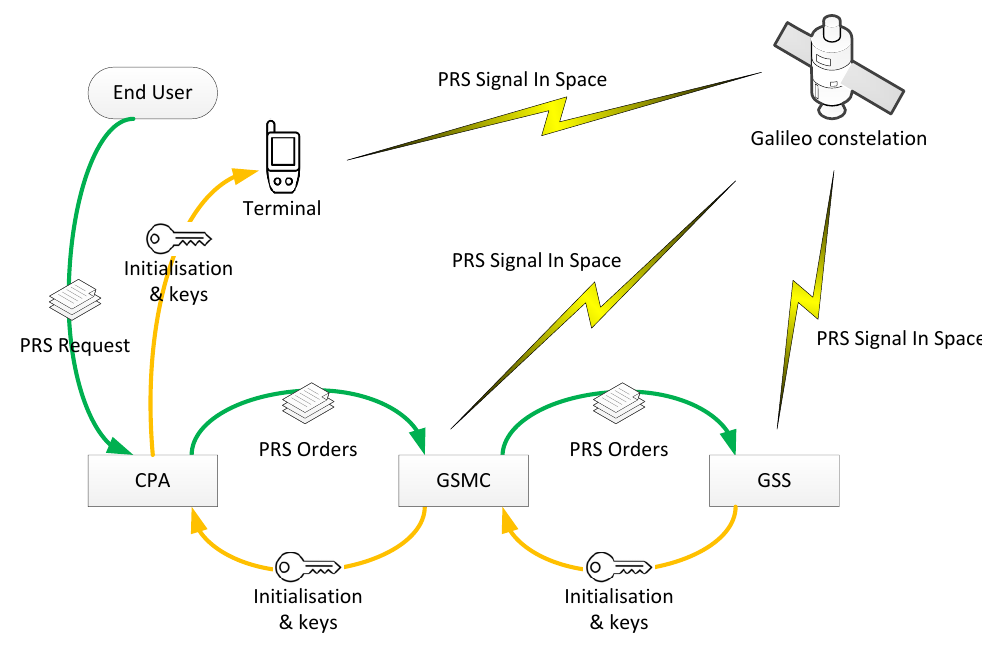
Figure 2. PRS keying procedure .